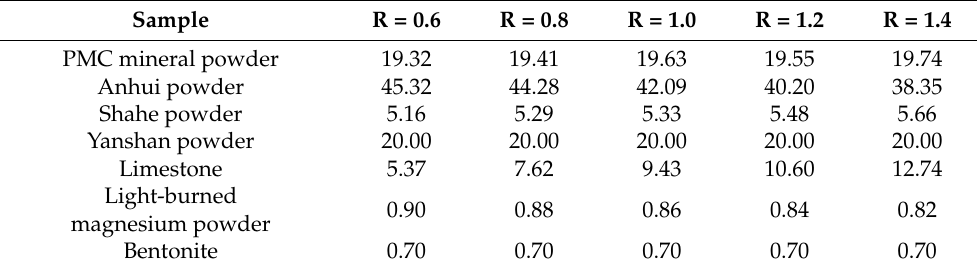
Table 4. Adjustment of alkalinity content and ore blending scheme.